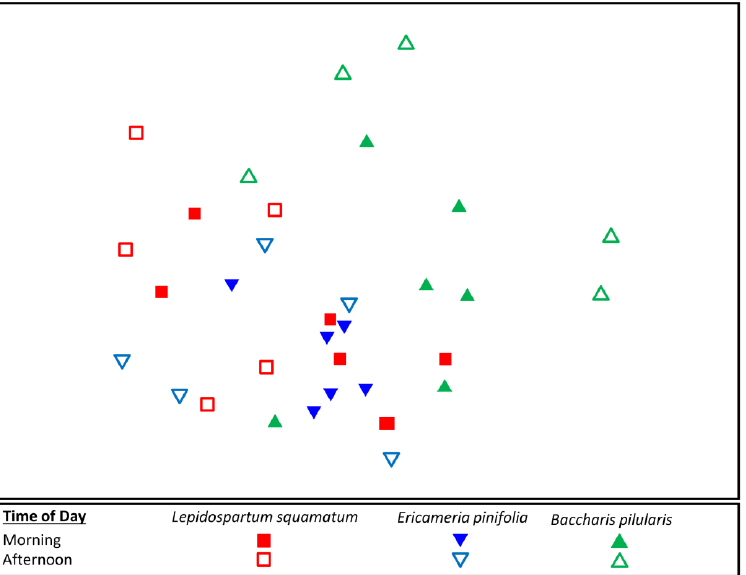
Table 9. Pairwise comparisons between plant assemblages. An asterisk denotes significance using a modified α -value of 0.016 to account for multiple testing. * denotes p < 0.016.